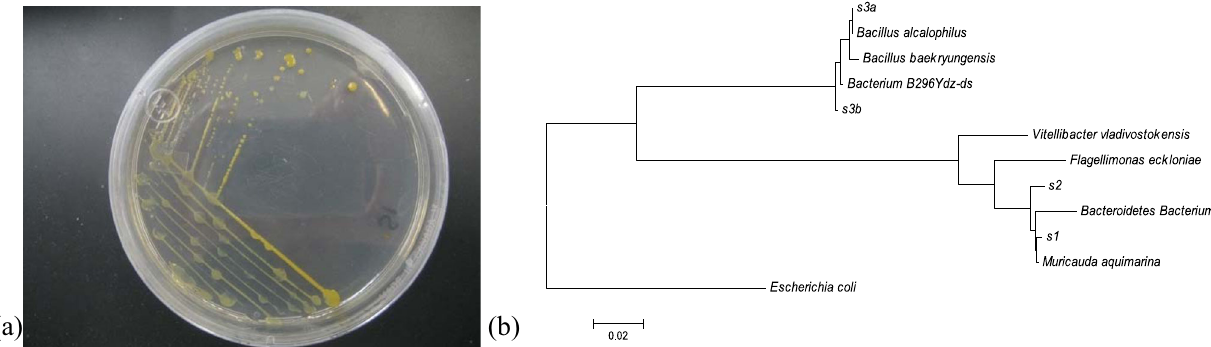
Fig. 2 Bacteria culture and phylogenetic tree from brackish groundwater RO plant. Unpublished culture plate image ( a ) and published phylogenetic tree ( b ) from the cited RO membrane autopsy project at the Long Beach Water Departments ’ s (Long Beach, California, USA) seawater desalination plant 15 . Copyright